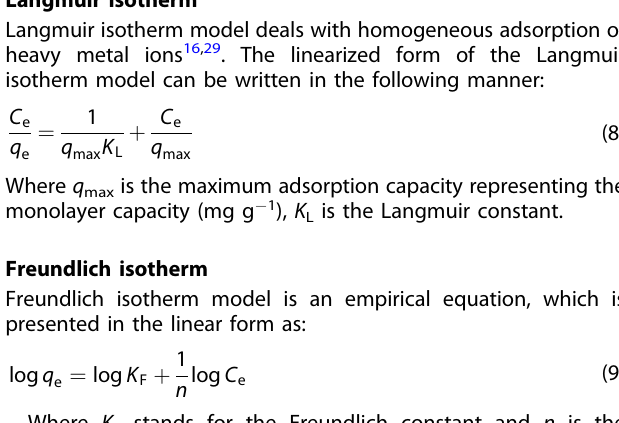
Fig. 6 Plots of equilibrium isotherm models. a Langmuir (high/low salinity); b Freundlich (with/without oil); c Freundlich (with/without the aeration). (Experimental conditions: pH 7, current density 25 mA cm − 2 , salinity 43.5 g L − 1 , cadmium concentration: 10 – 40 mg L − 1 ). Error bars represent standard